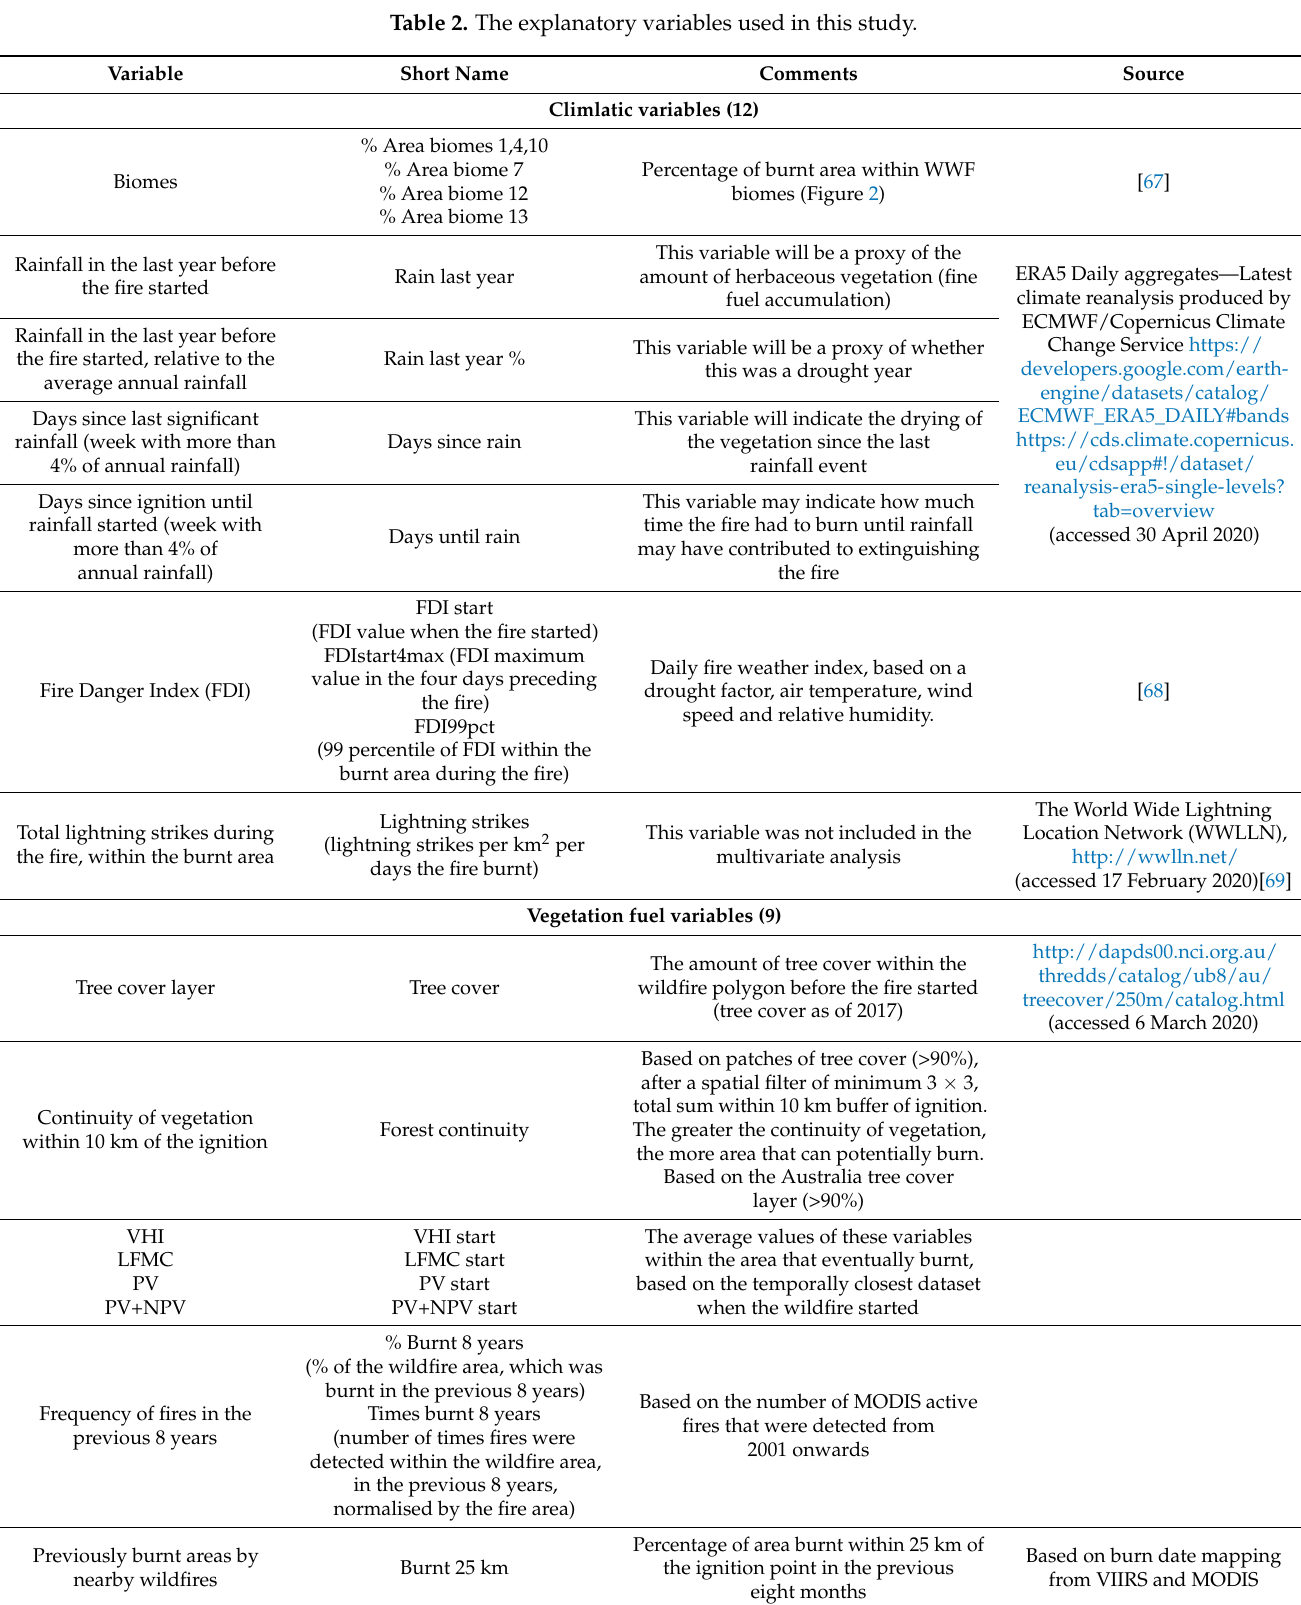
Table 2. The explanatory variables used in this